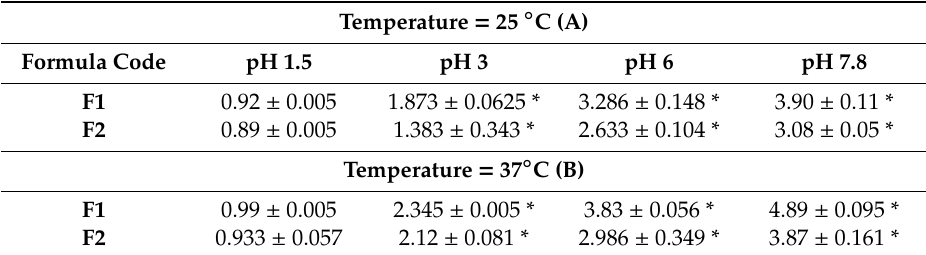
Table 1. Swelling index at pH 1.5, 3, 6 and 7.8 for 25 °C (A) and 37 °C (B). N = 3, mean ± SEM. F1: PB–LVSA microcapsules and F2: PB–ULCA–LVSA microcapsules. PB—probucol; LVSA—low viscosity sodium alginate; ULCA—unconjugated lithocholic acid. *p < 0.01.